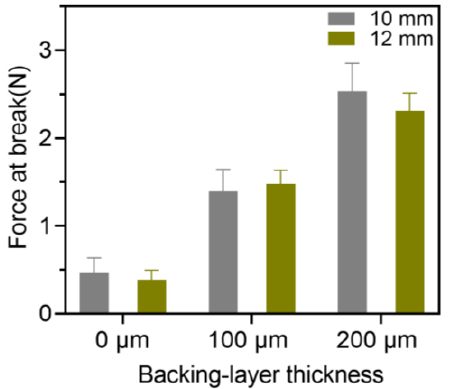
Figure 10. Breaking force of the 3D-printed bilayer oral films (n = 6).